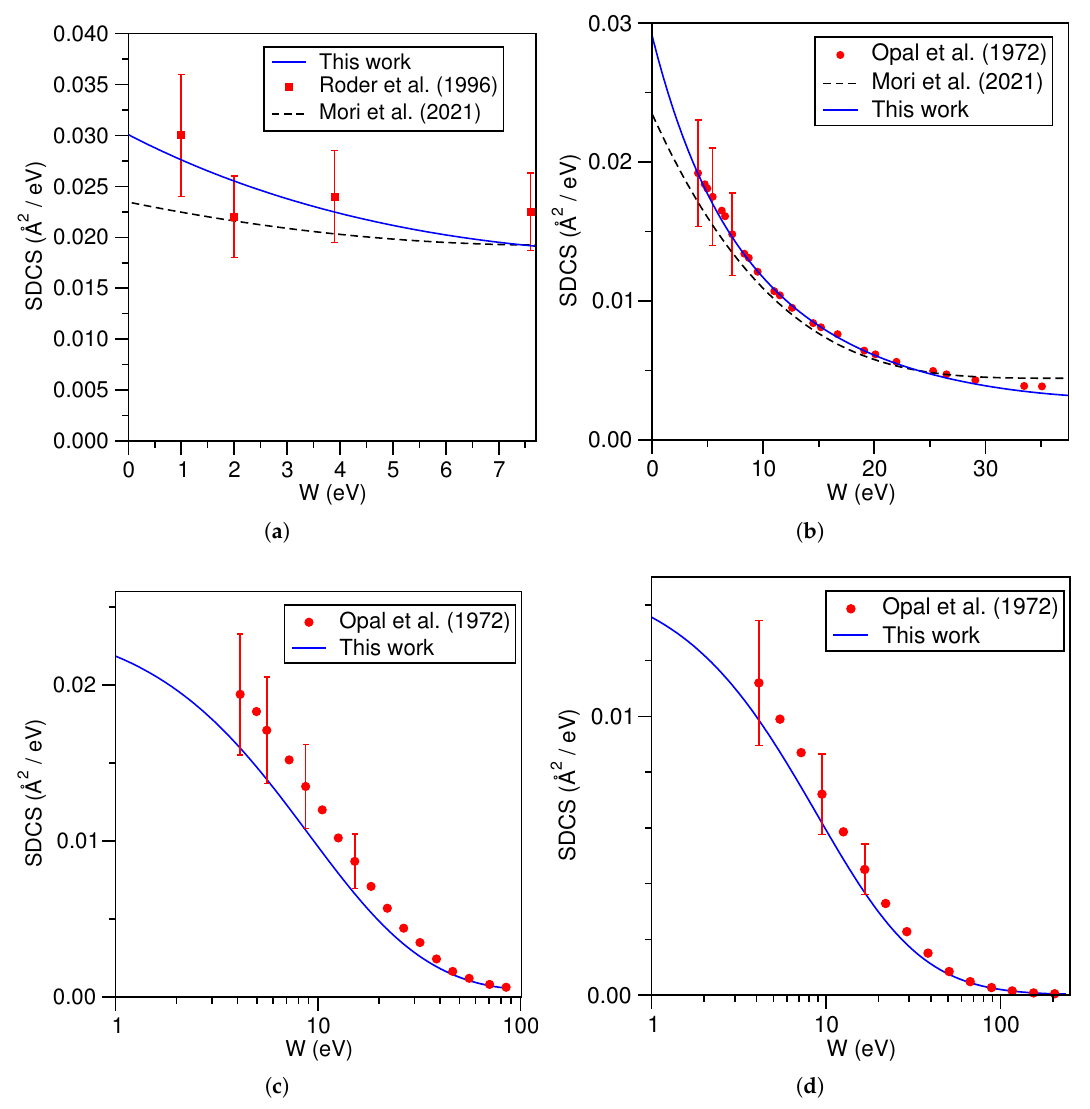
Figure 2. Electron-impact SDCS for electron-impact ionization of He-atom at a primary electron energy of ( a ) T = 40 eV, ( b ) T = 100 eV, ( c ) T = 200 eV, and ( d ) T = 500 eV. The solid lines represent the present results, the dashed lines represent the theoretical results of Mori et al. [33], the filled circles represent the experimental measurements of Opal et al. [35], and the filled squares represent the experimental results of Röder et al.